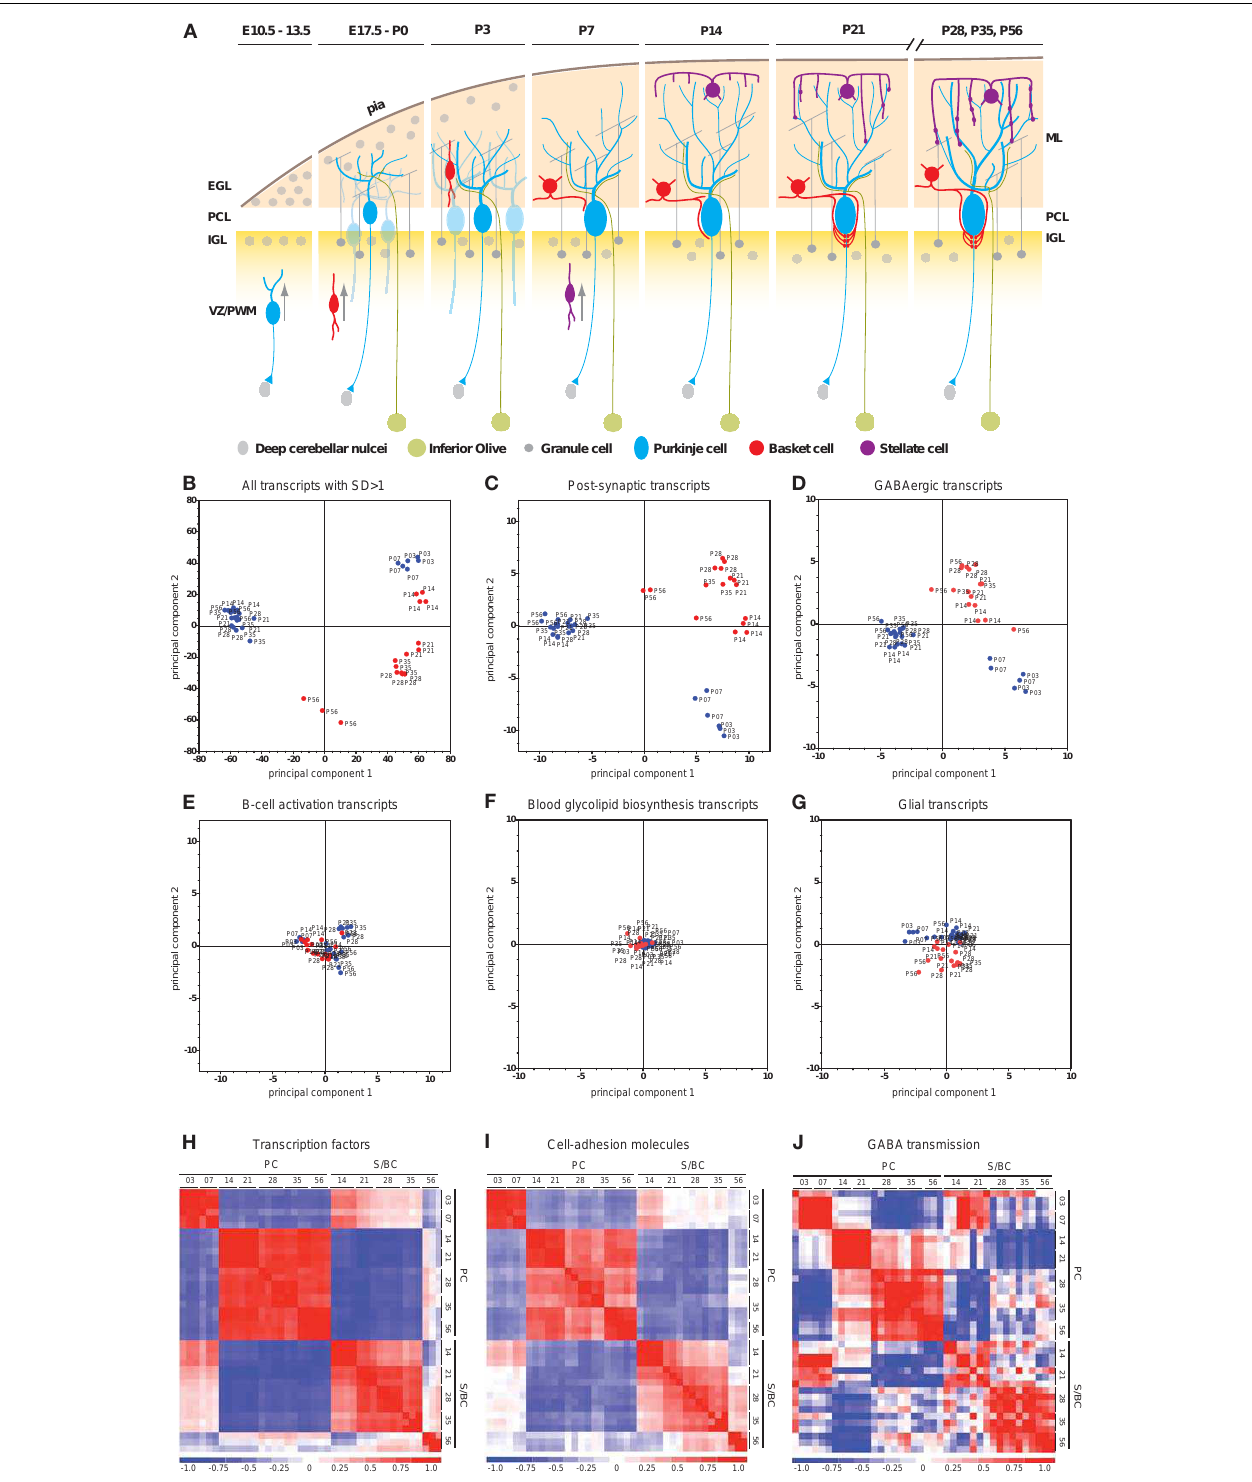
(SD > 1 of mean, p < 0.05) across all time points can clearly segregate PCs (blue) and S/BCs (red) (B) . PCA based on all postsynaptic protein transcripts (C) , encoding membrane proteins such as ion channels, cell adhesion